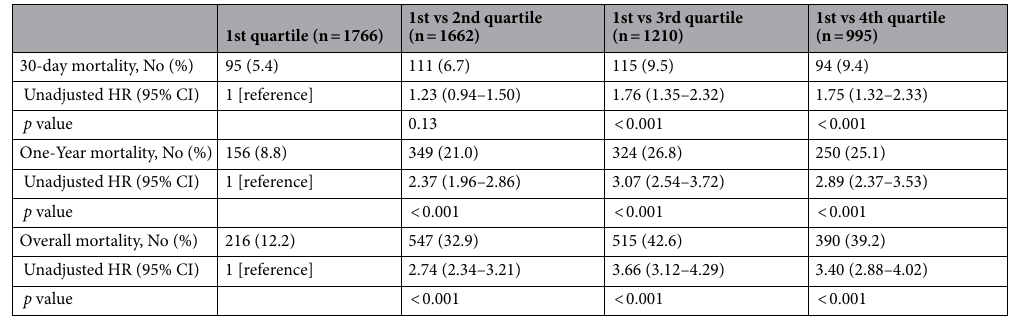
Table 3. Clinical outcomes according to quartiles of the CCI. Values are n (%). CCI Charlson Comorbidity Index, HR hazard ratio, CI confident